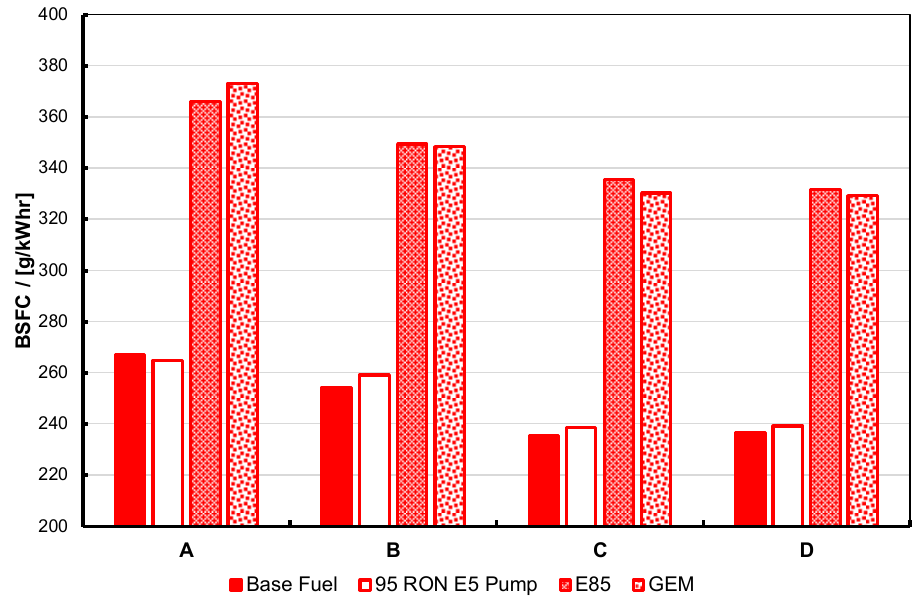
Figure 9. BSFC at maximum torque for the base and 95 RON pump gasolines, E85 and the GEM blend, at four different fixed-intake conditions, operated at KLSA ignition timing. For description of the test operating points, labelled A to D here, see Table 3 and text. Note that the two high-alcohol blends have nearly-matched stoichiometry and enthalpy of vaporization, RON and MON, and as a consequence perform in an essentially identical manner.